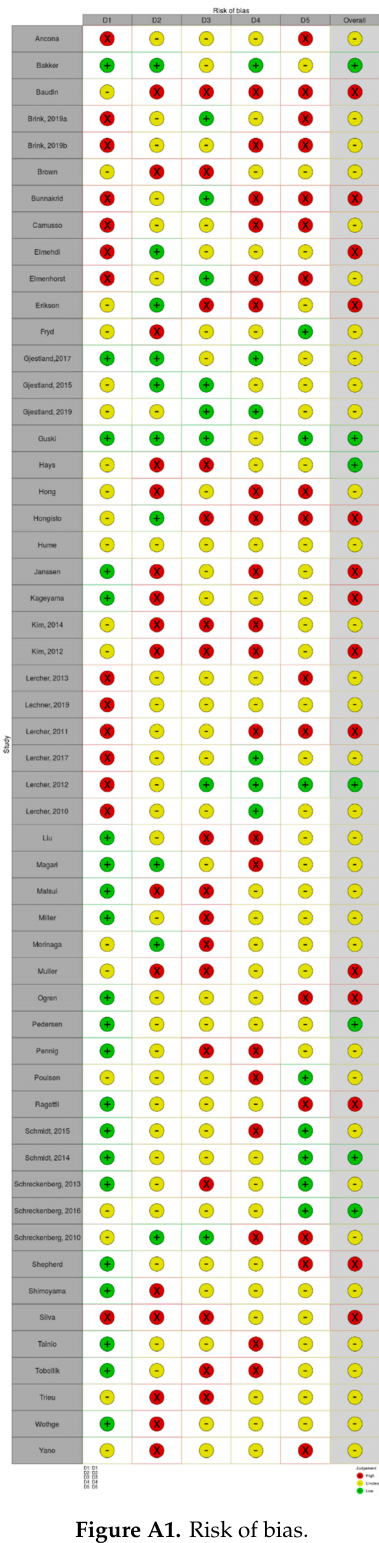
Figure A1. Risk of